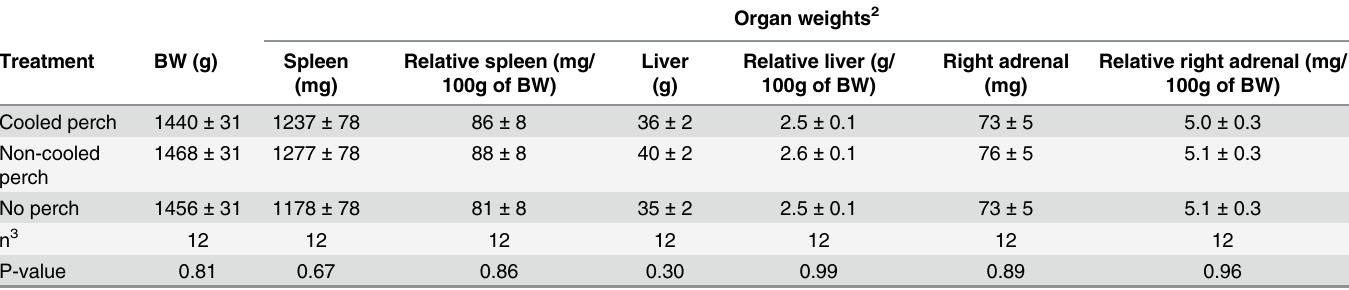
Table 2. The effect of thermally cooled perches on body and organ weights of 32-week-old White Leghorn hens 1 in 2013 summer hot months including 31 days after an acute heating episode.